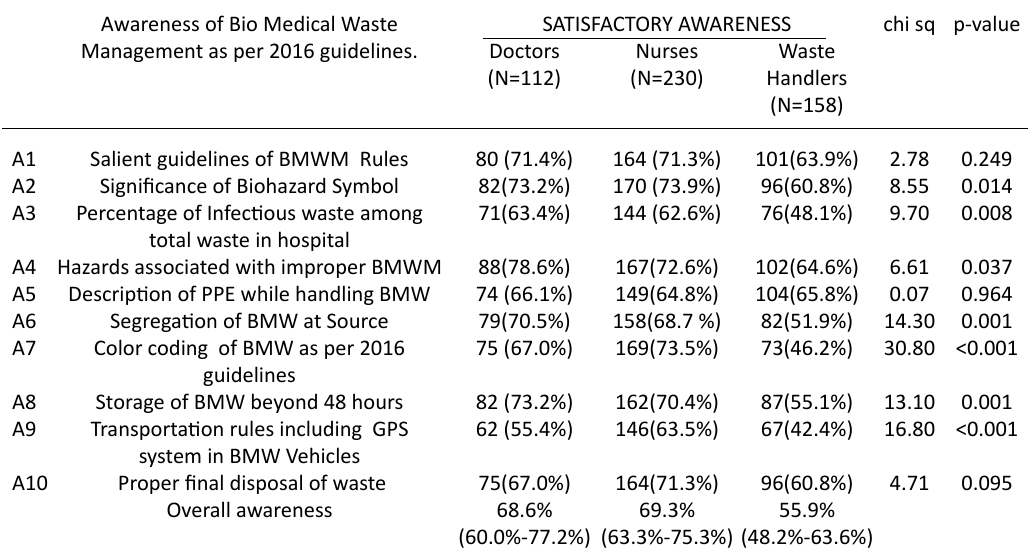
Table 2. BMWM awareness among health care personnel Awareness of Bio Medical Waste SATISFACTORY AWARENESS